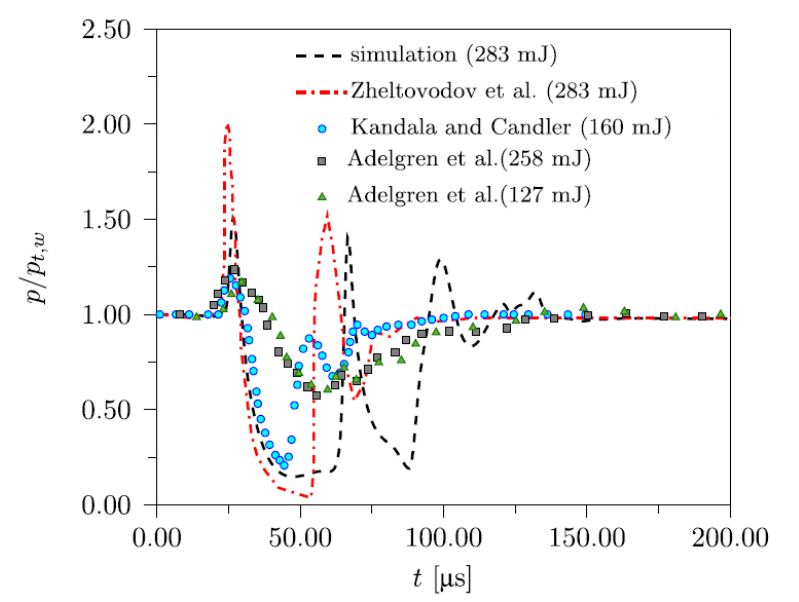
Figure 43. Centerline pressure versus time. Adapted from [86].